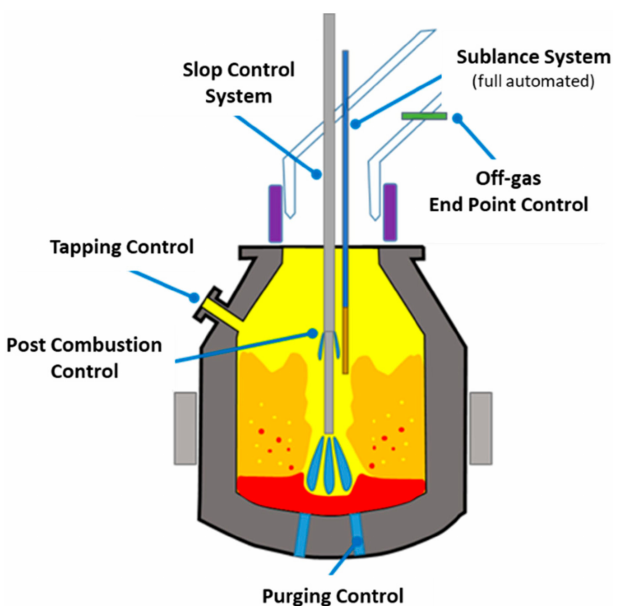
Figure 5. Overview of the technological innovations in the LD